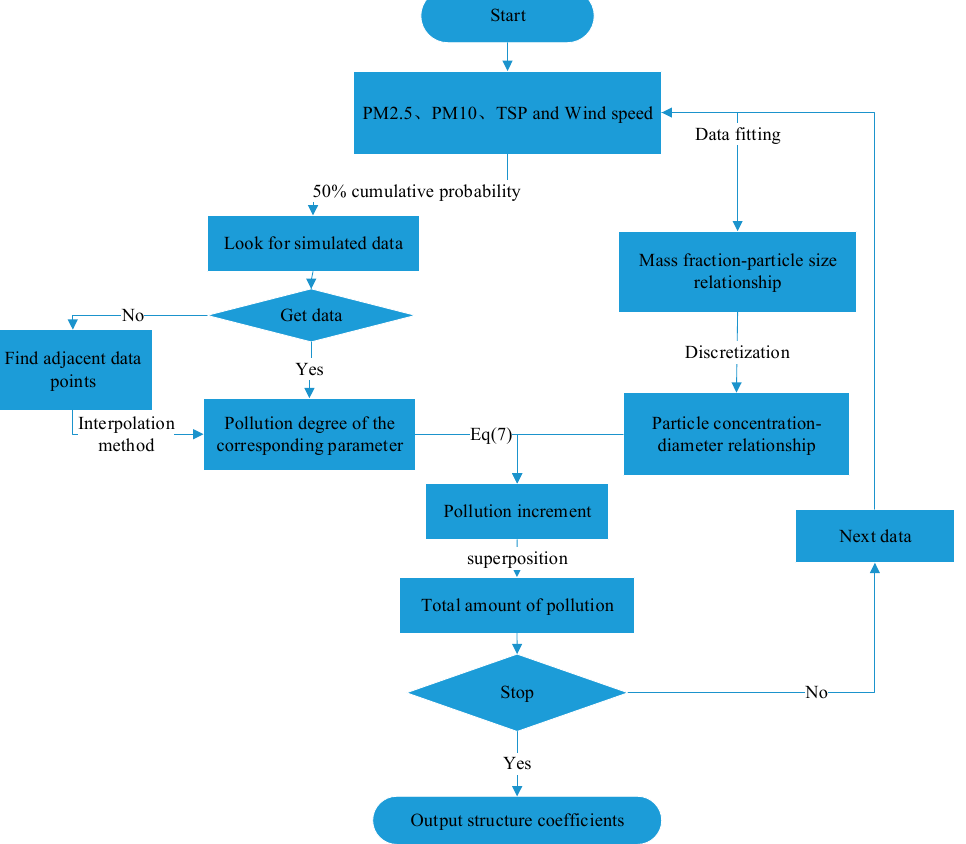
PM2.5 、 PM10 、 TSP and Wind speed